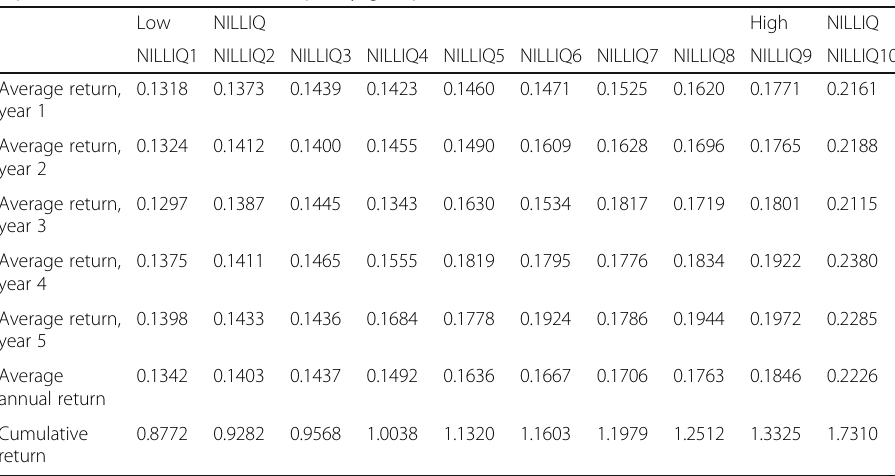
Table 3 Average returns, normalized illiquidity portfolios. Ten portfolios are formed using normalized illiquidity for the pre-portfolio formation year ending in April for each year in the 33-year period between 1968 through 2000 for all AMEX and NYSE stocks identified on CRSP. For each year, returns are extracted for the subsequent 60-month period. Annual return is then calculated using these monthly returns for May through April of each of the five post-portfolio formation years. If a stocks monthly returns disappear then the investor is assumed to invest for the remainder of the year in a randomly chosen stock within the same decile grouping on the basis of market capitalization. The normalized illiquidity, NILLIQ, is calculated using the methodology detailed in the description of Table 2. The average values across the 33 years in the sample of the annual returns are reported in this table for each of the five post-portfolio formation years. As well, the average annual return and cumulative return are reported for each normalized illiquidity group Low NILLIQ High